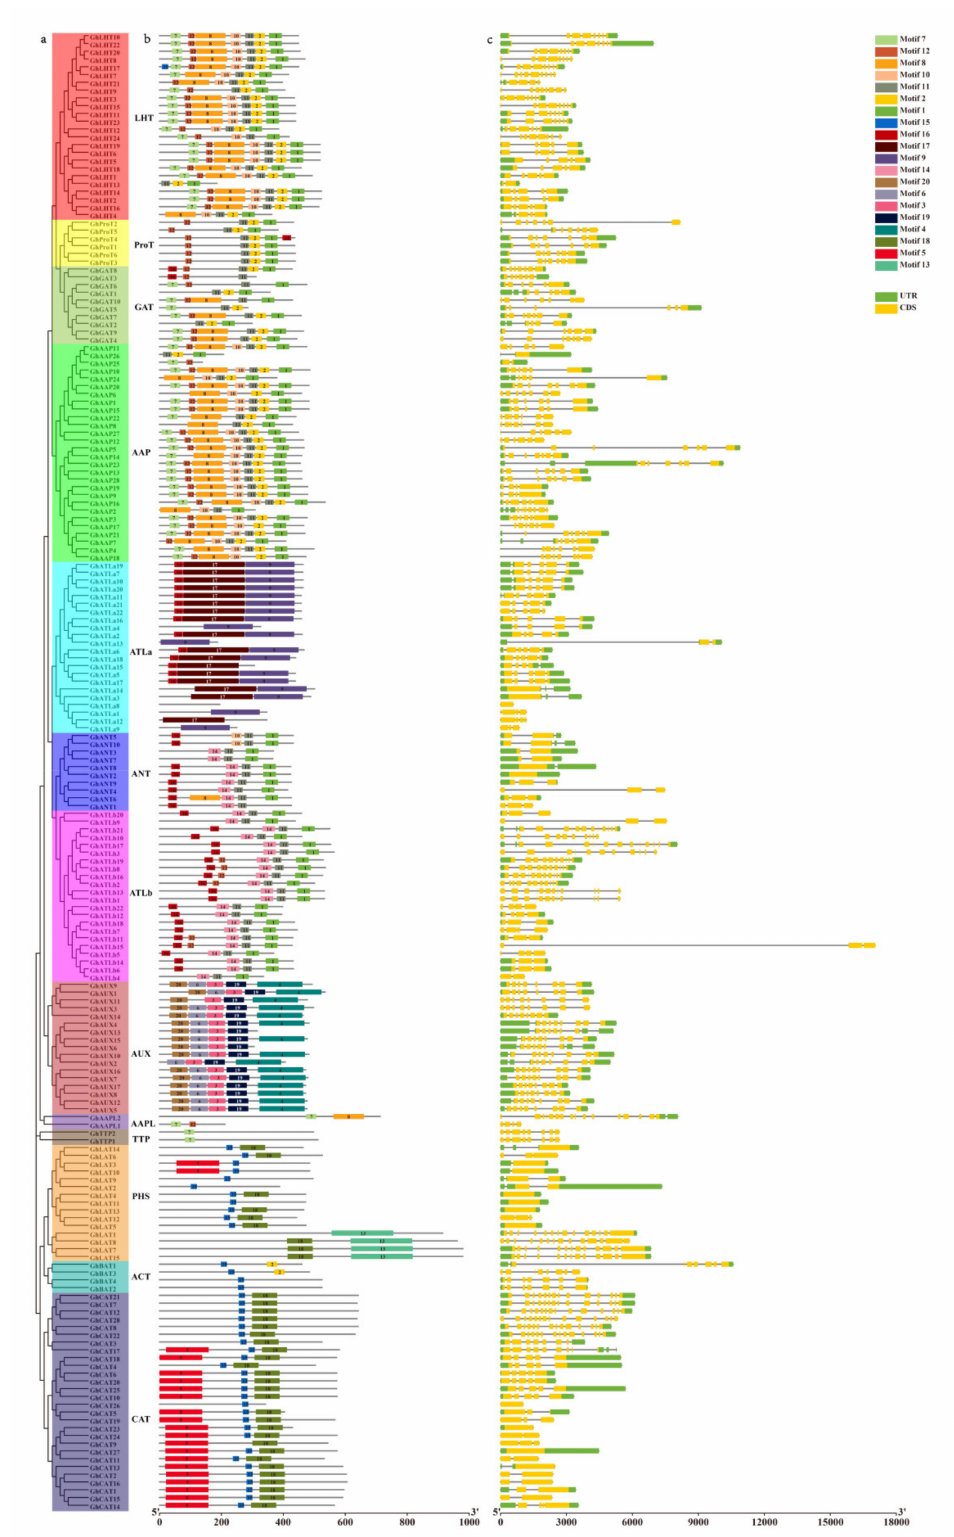
Figure 5. Phylogenetic relationships, protein domains, and gene structure analysis of GhAATs . ( a ) Phylogenetic analysis of GhAATs proteins using MEGAX via the maximum likelihood (ML) method. ( b ) The conserved protein motifs of the amino acid sequences of GhAATs were analyzed by the MEME. ( c ) The gene structures of GhAATs . Gene structure analysis was performed by Gene Structure Display Server (GSDS). The CDSs, untranscipted regions (UTRs) and introns are indicated with yellow rectangles, blue rectangles, and black lines,